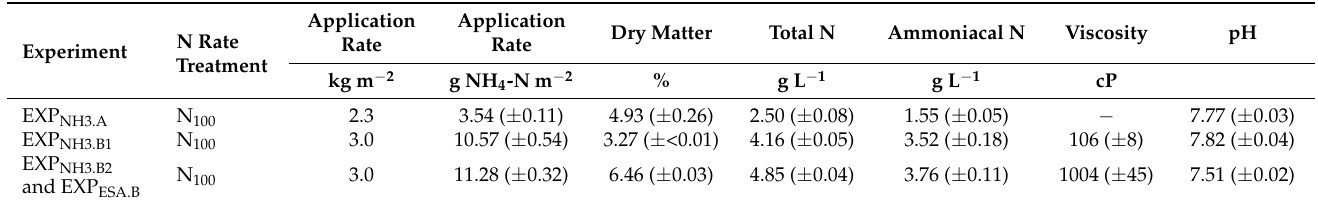
Table 2. Slurry properties and application rate used in EXP NH3 and EXP ESA . Standard errors are displayed in